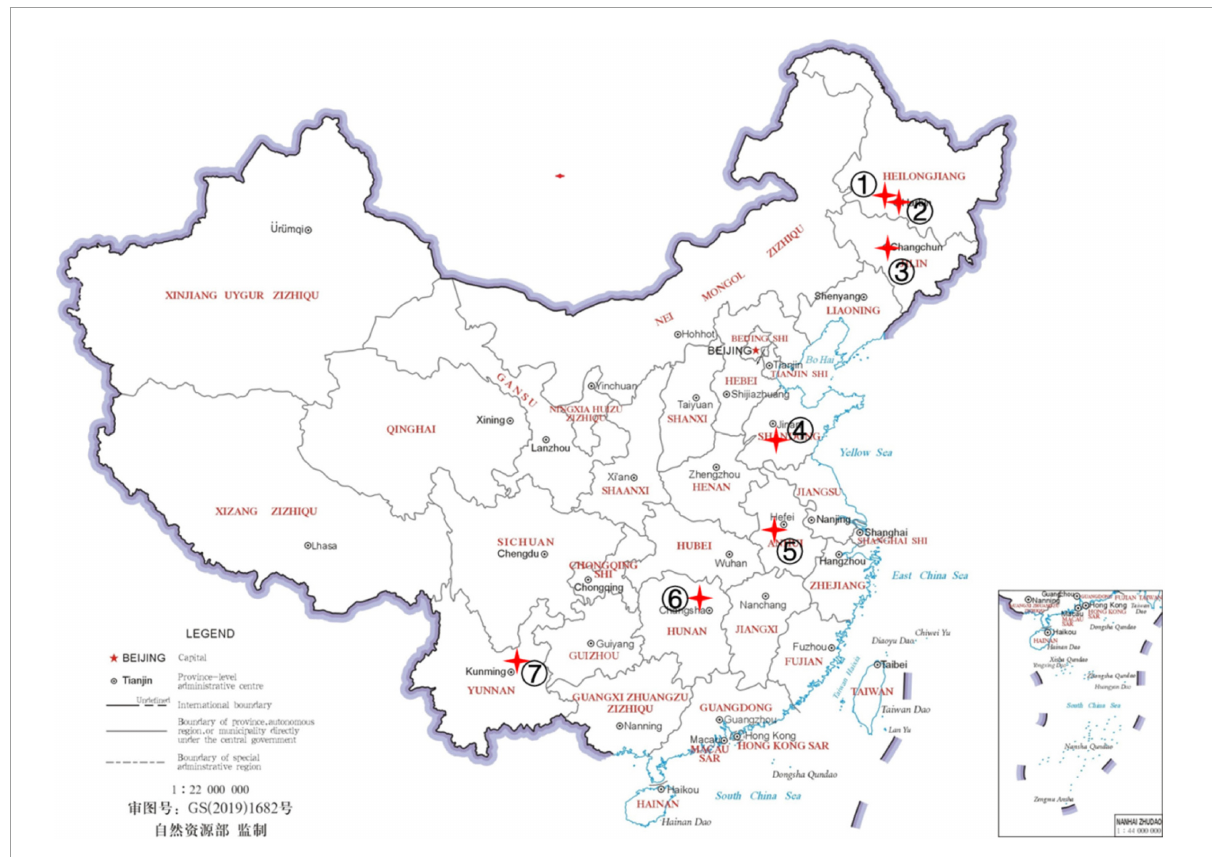
FIGURE1 Collection localities for Psylliodes attenuata . The map was downloaded from http://bzdt.ch.mnr.gov.cn. The locations of sampling sites are noted with numbers and red cross on the map. The details of P. attenuata collections were shown in Table 1